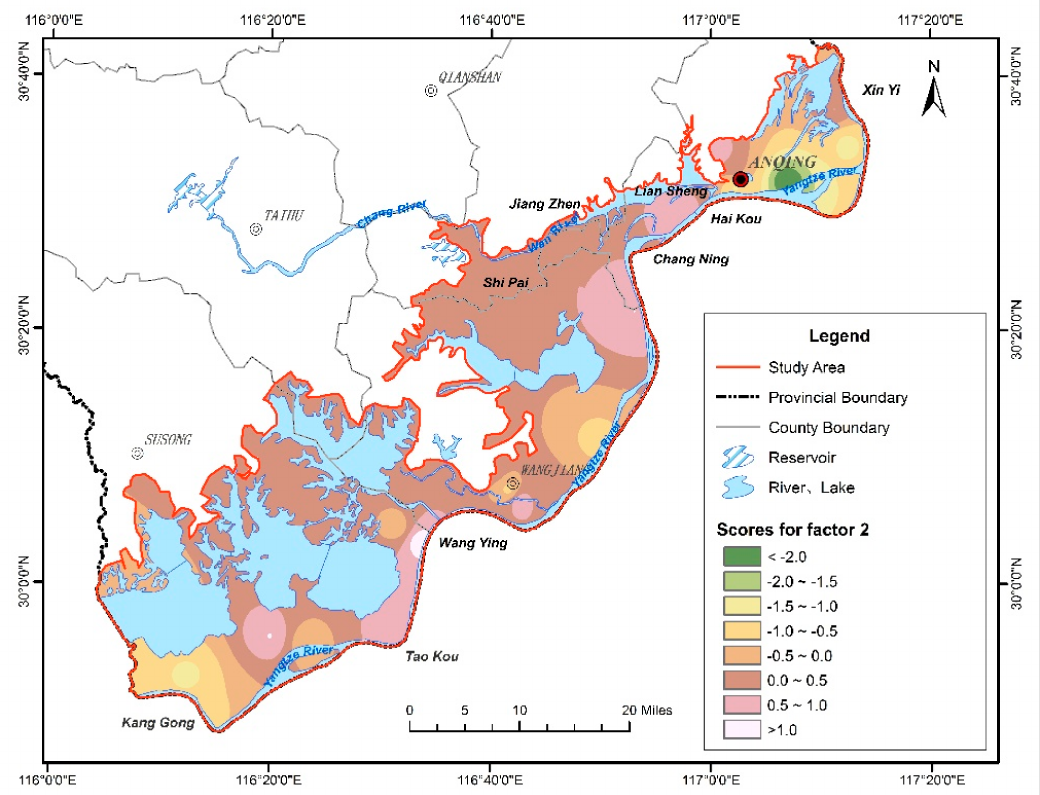
Figure 7. Distribution of scores of factor 2 for phreatic water.